Question: Which visualization type does this figure use?
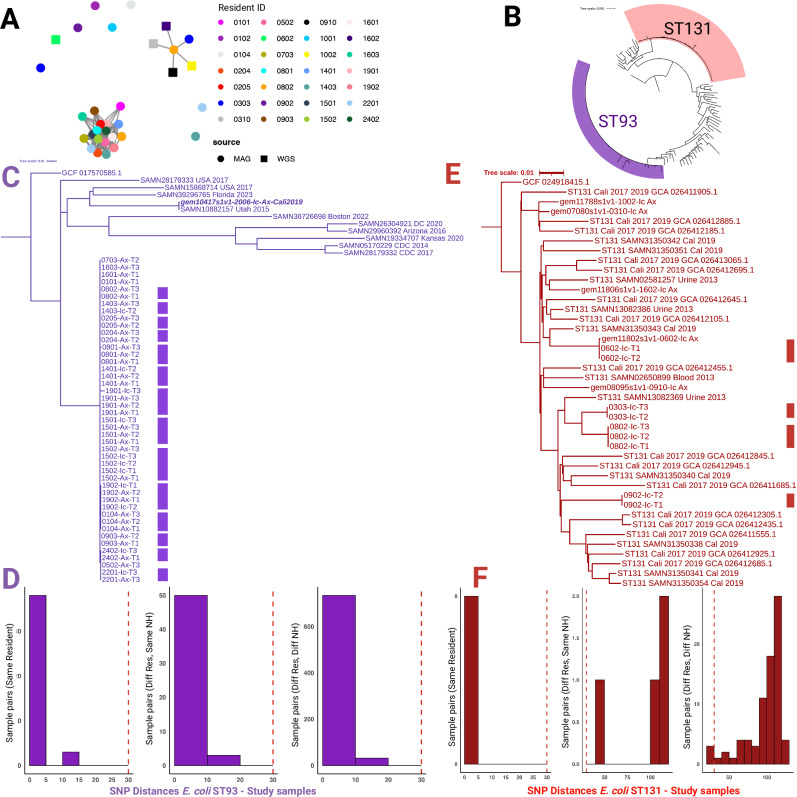
Answer: histogram